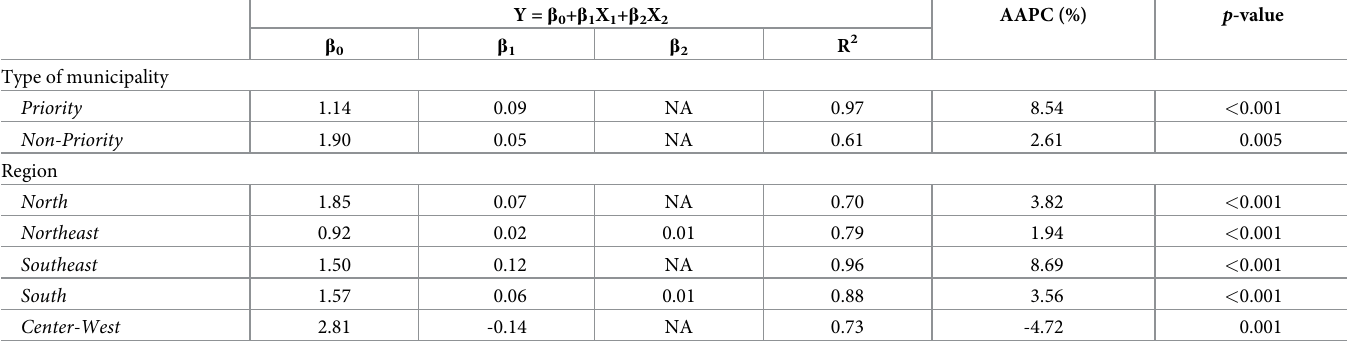
Table 4. Trend analysis of the ratio between syphilis in pregnancy and congenital syphilis in priority and non-priority municipalities and according to regions of Brazil, from 2007 to 2017. Database: National System of Aggravations and Notification—SINAN